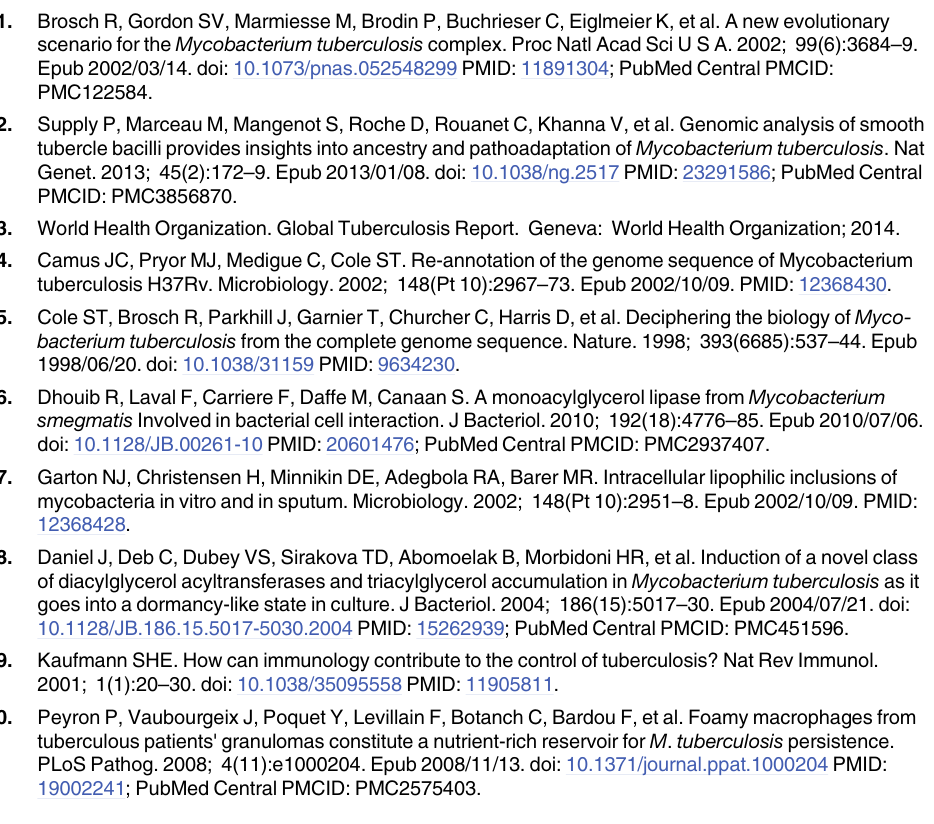
S3 Fig. Cell-mediated immune response of LipL. Histograms showed the CD3 + CD8 + T cell subsets and the CD3 + CD4 + T cell subsets from LipL and PBS immunized mice. (A) The per- Ms group was significantly higher than that of the centage of CD3 + CD8 + T cells in the LipL Ms group was significantly control group. (B) The percentage of CD3 + CD4 + T cells in the LipL Ms decreased compared with the control group (day 21 not significant). (TIF) S4 Fig. The lipase activity of LipY. Lipase activity of LipY towards p -NP esters with various chain lengths (C2, acetate; C4, butyrate; C6, caproate; C8, caprylate; C12, laurate; C14, myris- tate; C16, palmitate; and C18, stearate). The values represent the means ± SD of three indepen- dent experiments.